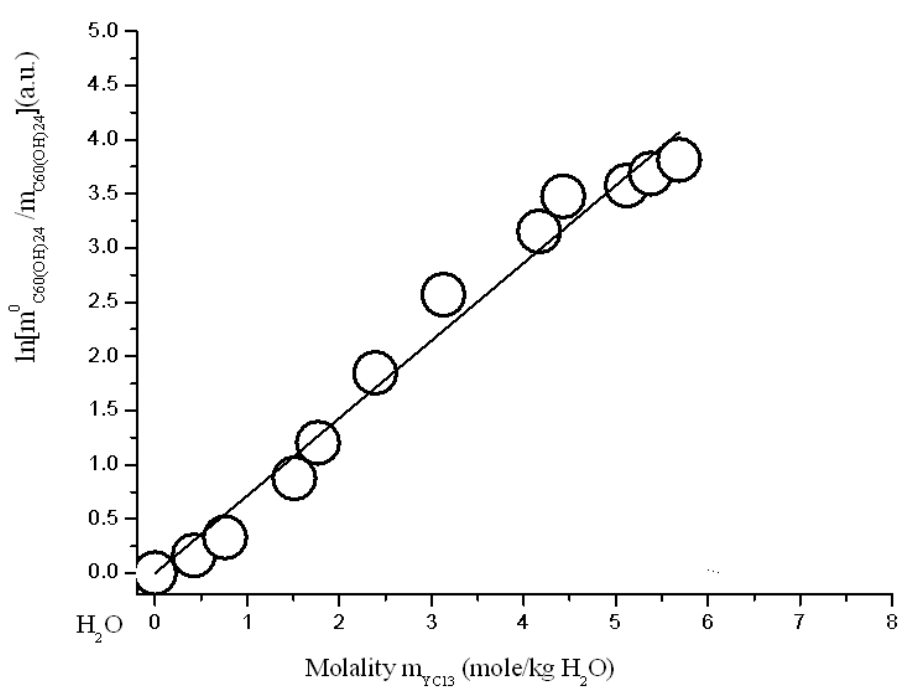
Figure 13. Branch of crystallization C 60 (OH) 24 *18H 2 O in the diagram of solubility in ternary system С 60 (ОН) 24 —YCl 3 —H 2 O